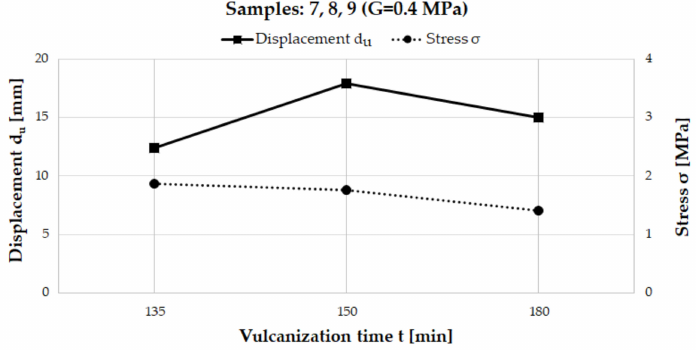
Figure 15. Test results in terms of displacement and stress for samples 7, 8, 9 (G = 0.4 MPa) for various vulcanization